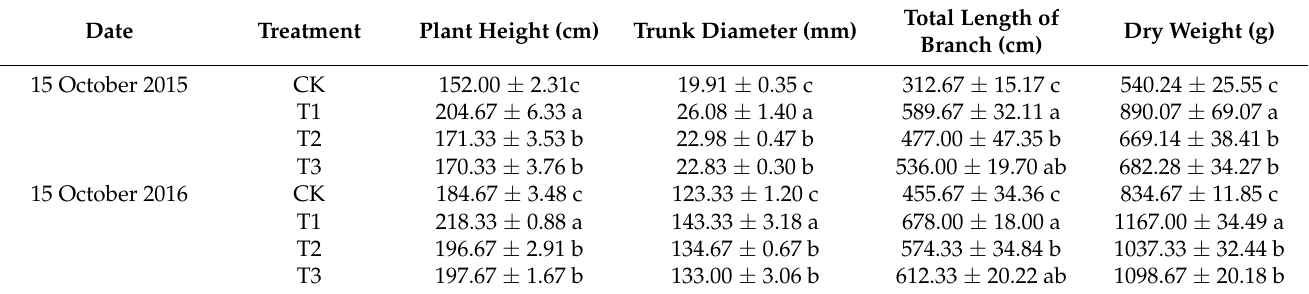
Table 1. Effect of mixed cropping with A. fistulosum and B. juncea on biomass of apple grafted seedlings. T1, grafted seedlings replanted on the soil fumigated with methyl bromide; T2, grafted seedlings replanted on the soil mixed cropping with A. fistulosum ; T3, grafted seedlings replanted on the soil mixed cropping with B. juncea .; CK: grafted seedlings replanted. Data of biomass were calculated in October 2015 and in October 2016. Data are the means of three replicates ( ± SE), different letters indicate significant differences at p <